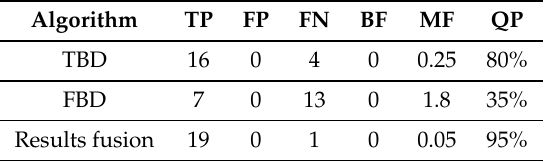
Table 8. Accuracy assessment of applying BDSV on Ist8, which includes 20 building